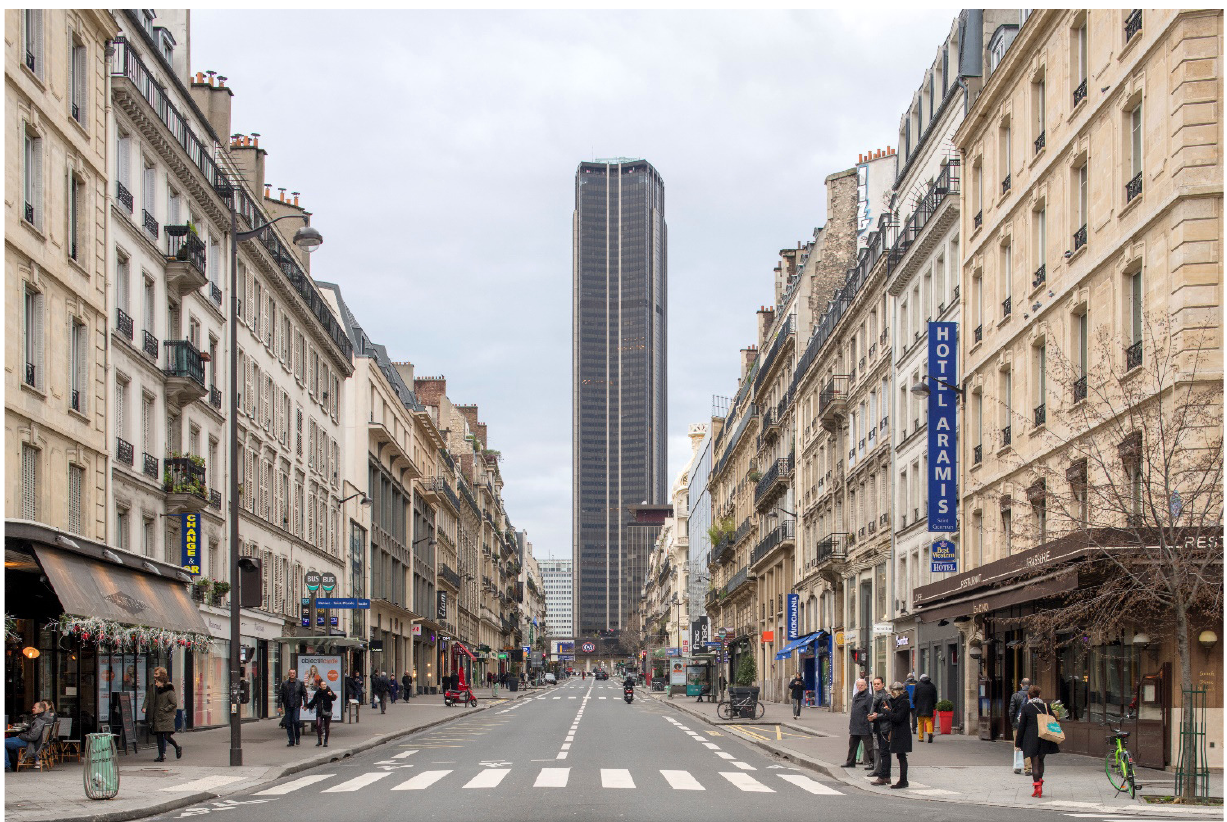
Figure 1. Tour Montparnasse, Paris. Source: Photo by © Martin Argyroglo. Urban Planning, 2022, Volume 7, Issue 4, Pages